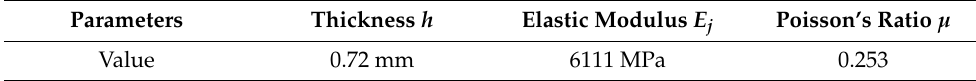
Table 11. Parameters of the transition interface model.